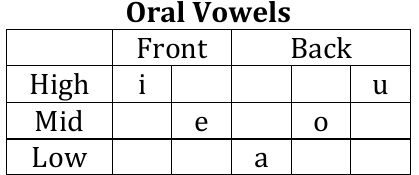
Table 1: 5 oral vowels in Deori